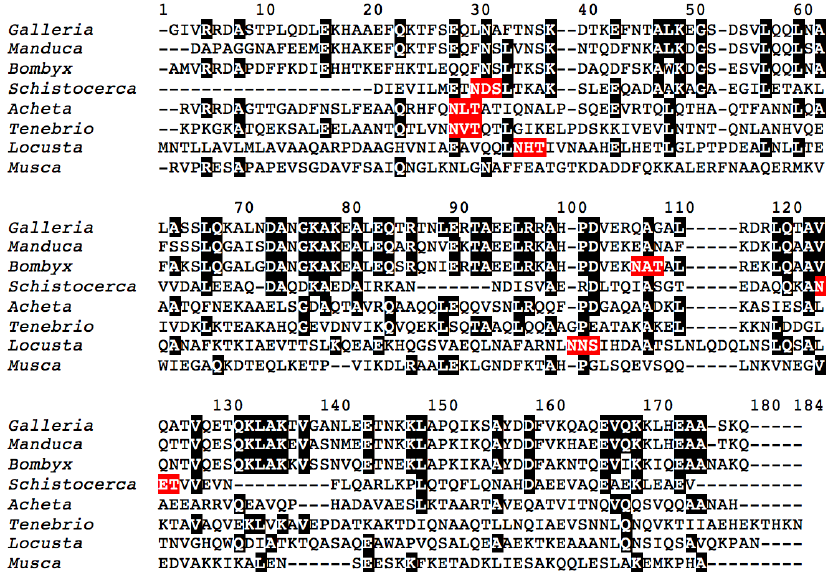
Figure 4. Multiple alignment of the apolipophorin-III protein from the edible insects Galleria mellonella, Manduca sexta, Bombyx mori, Schistocerca gregaria, Acheta domesticus, Tenebrio molitor, Locusta migratoria, and Musca domestica. Identical amino acid residues are in black boxed white letters. Putative N-glycosylation sites are colored red.